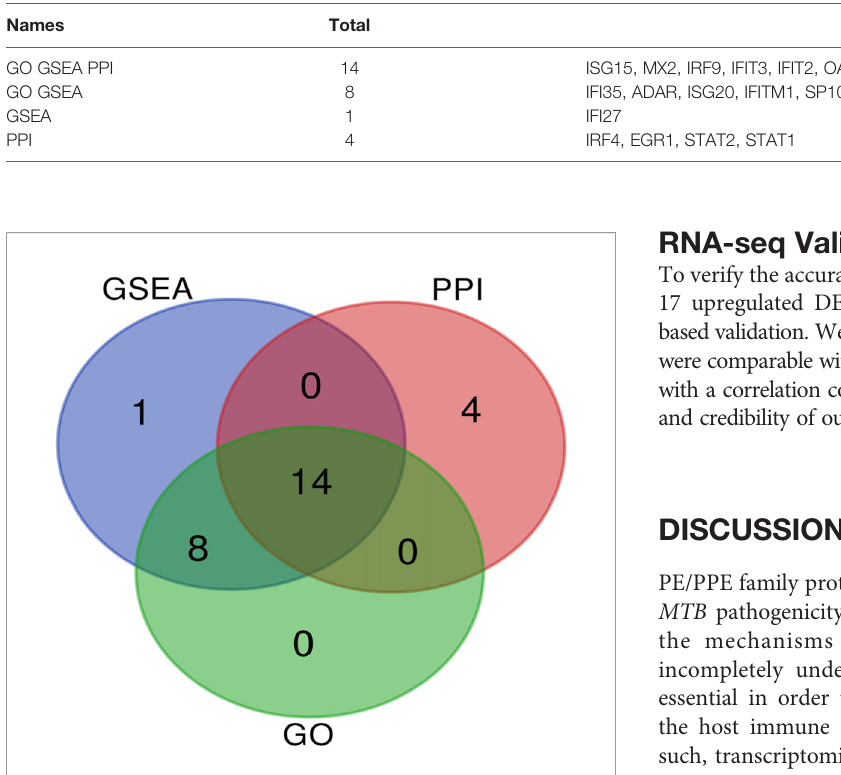
FIGURE 5 | Venn diagram demonstrating the number of common overlapping genes in GSEA, GO, and PPI analyses. These overlapping genes were related to the type I IFN signaling pathway. Genes analyzed via GSEA, GO, and PPI approaches are denoted in blue, green, and red circles, respectively. In total, 14 genes overlapped across all three of these